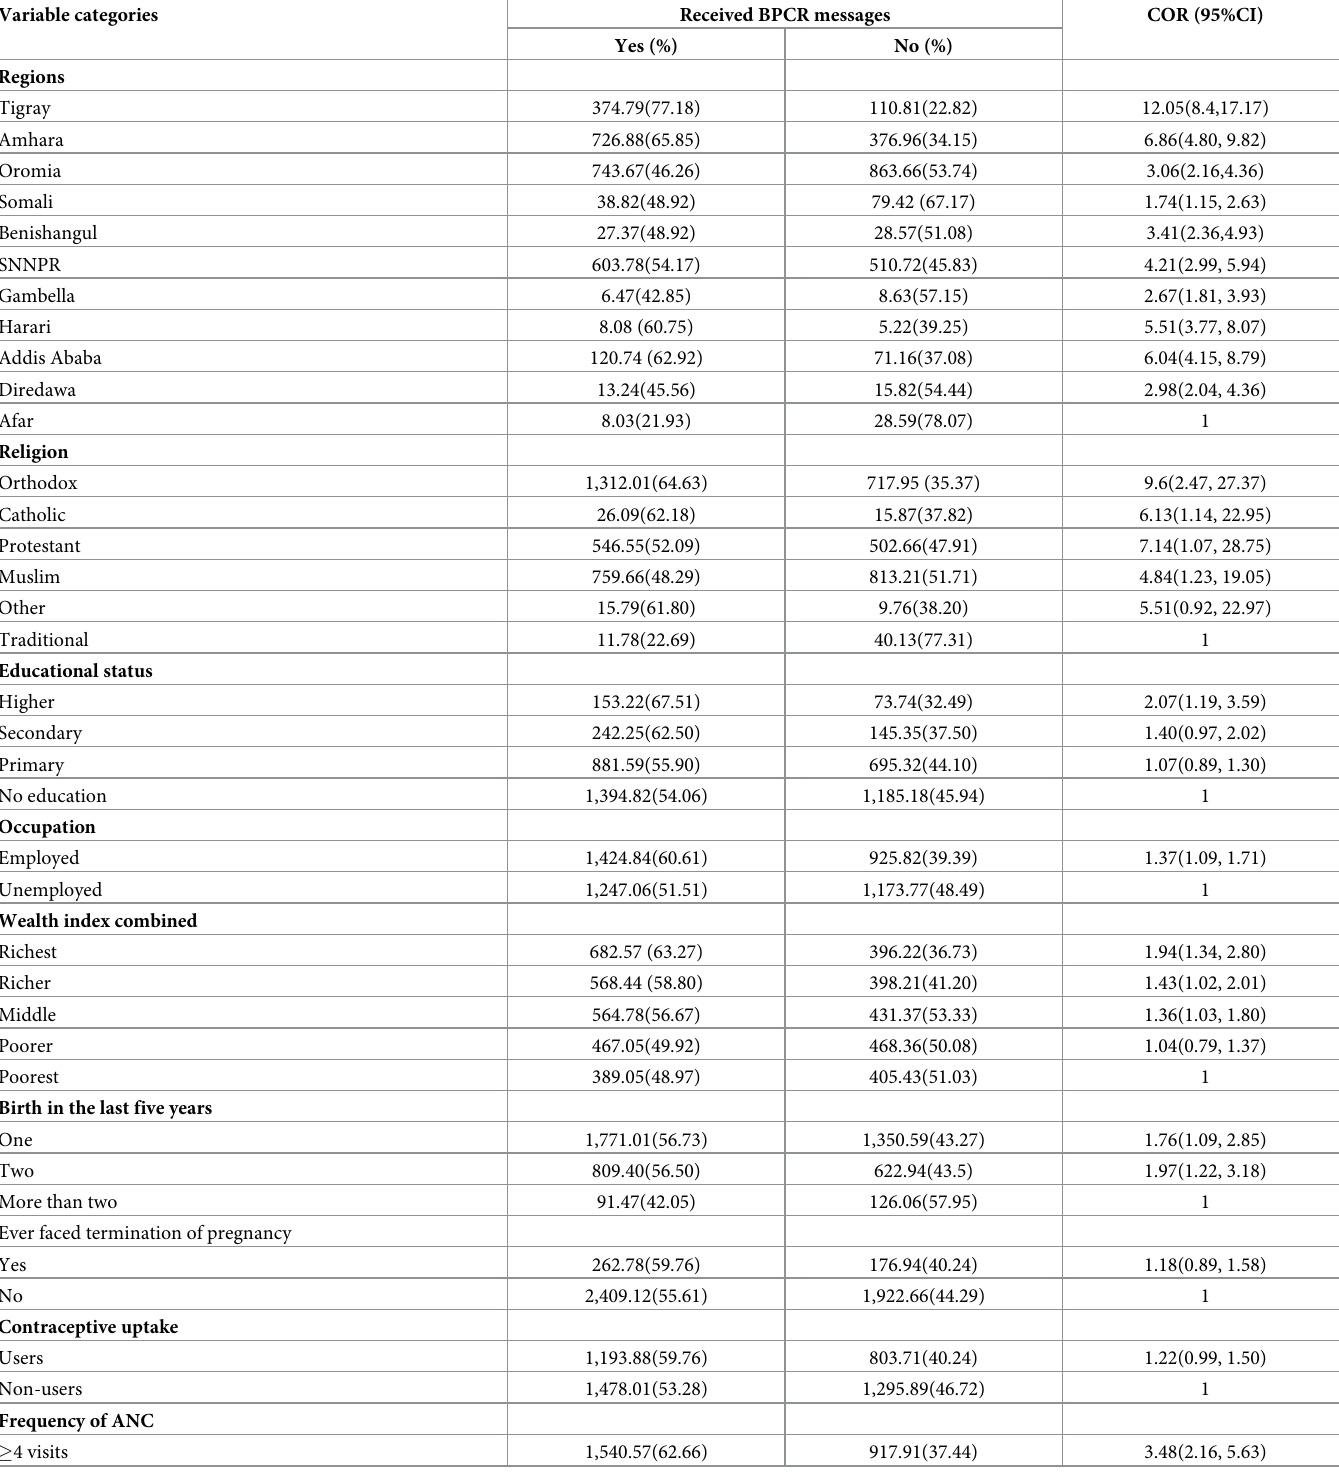
Table 4. Results of a multilevel bivariable logistic regression analysis to identify the factors associated the uptake of BPCR messages among pregnant women in Ethiopia, 2016. Variable